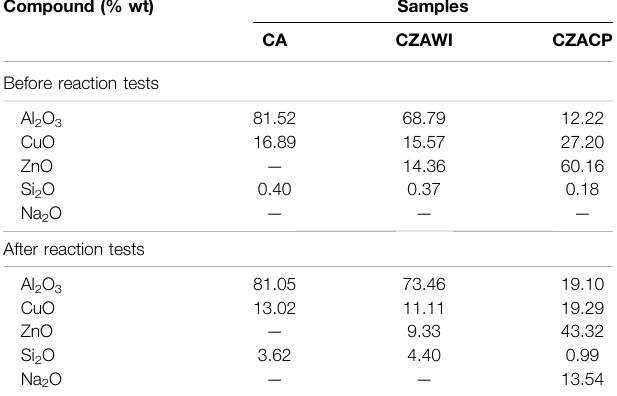
TABLE 2 | Composition of samples in oxides by X-ray fl uorescence.